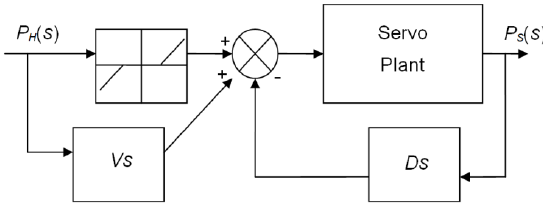
Figure 9. PD controller with dead-band limiter and velocity feedforward.